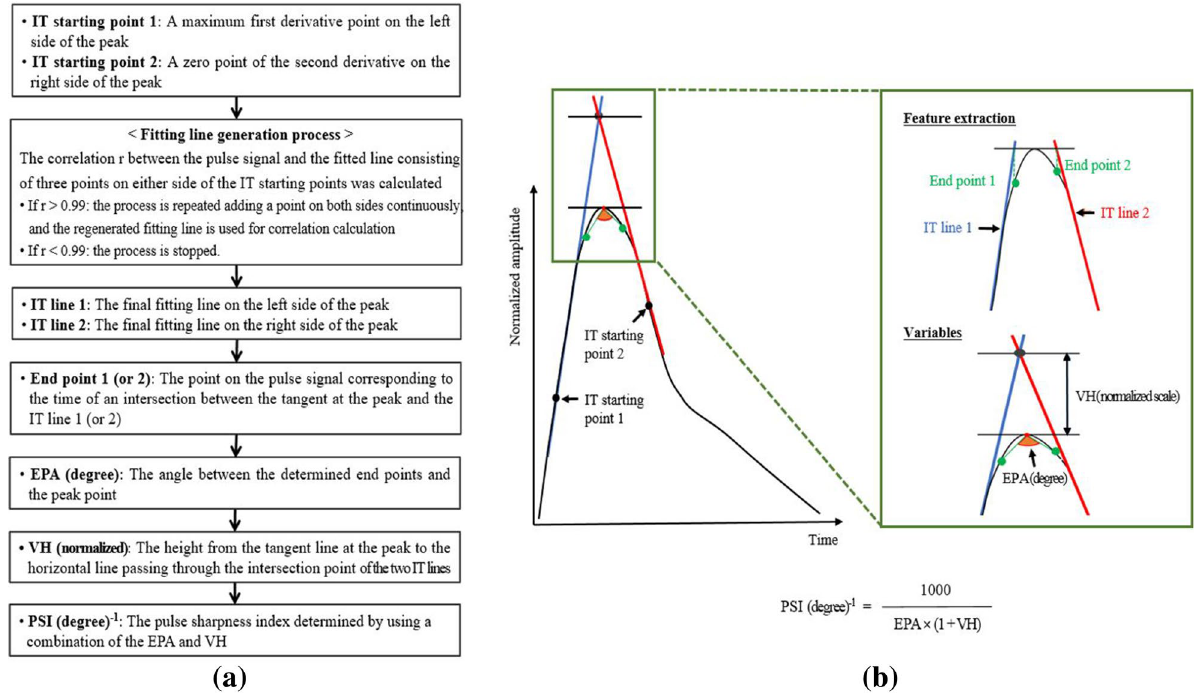
Figure 3. ( a ) Flowchart of feature extraction and calculation of the PSI, and ( b ) it’s graphical descriptions. IT intersecting tangent, EPA end point angle, VH virtual height, PSI pulse sharpness